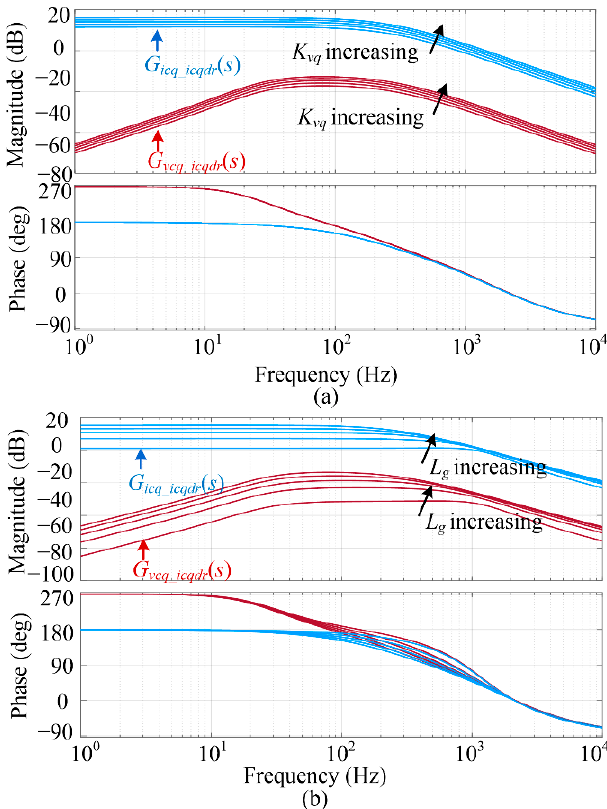
Figure 11. Bode plots of G icq _ icq dr ( s ) and G vcq _ icq dr ( s ) with ( a ) various K vq ; ( b ) various L g .